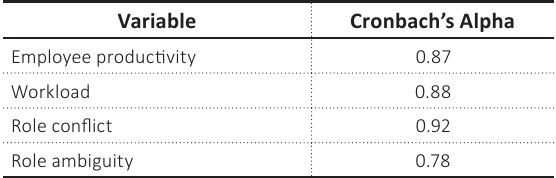
Table 1. Summary of reliability